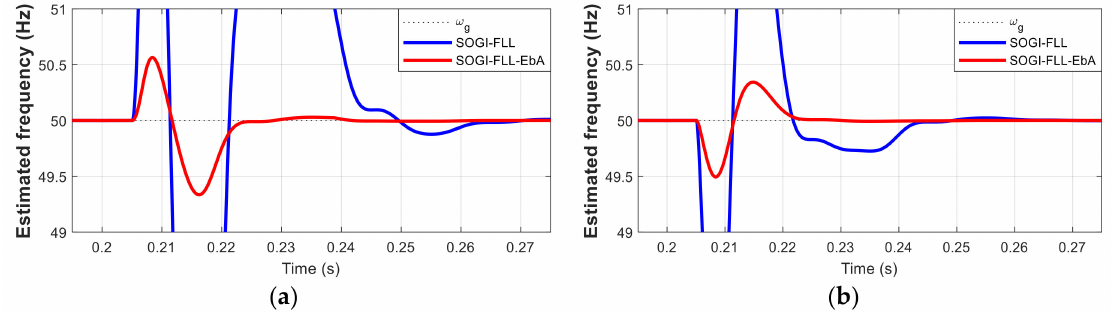
Figure 8. SOGI-FLL and SOGI-FLL-EbA estimated frequency transient responses to 0.2 pu voltage sag and 1.8 pu voltage swell at 0.205 s, respectively.